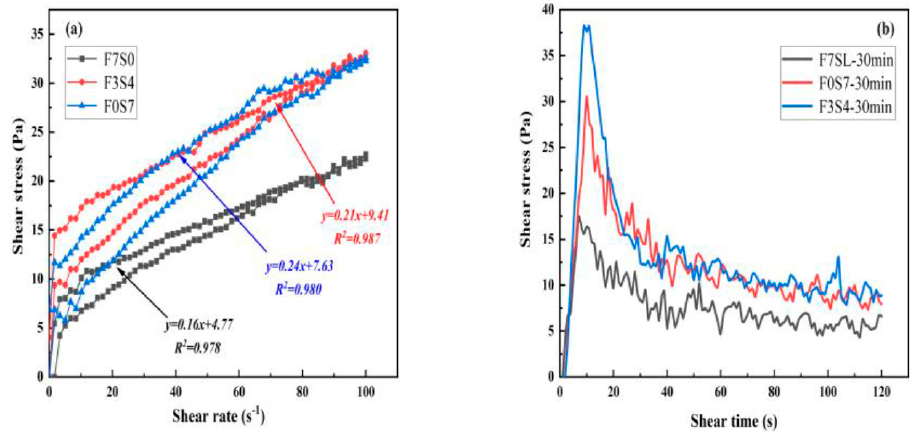
Figure 3. Rheological properties of the LCFLS: ( a ) dynamic yield stress at 0 min; ( b ) static yield stress at 30 min.